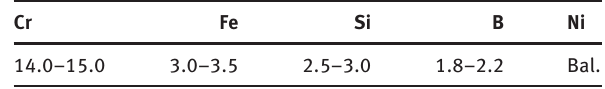
Figure 1: Morphology of NiCrBSi powder particles. Table 2: Composition of NiCrBSi alloy (wt%).